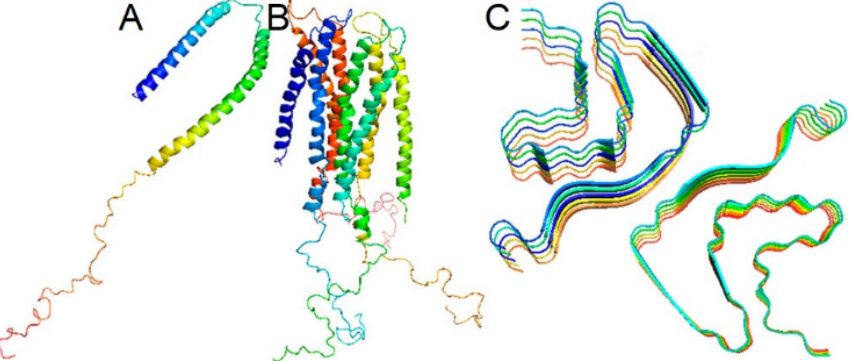
Figure 2. Micelle-bound, tetrameric, and fibrillar α -synuclein. ( A )— α -Synuclein is disordered under physiological conditions in solution. Disordered form is in equilibrium with a minor α -helical tetrameric form in the cytoplasm ( B ) α -Synuclein is α -helical when bound to a cell membrane ( C ) α -Synuclein may form polymorphic amyloid fibrils with unique arrangements of cross- β -sheet motifs. From Korneev et al. [30].